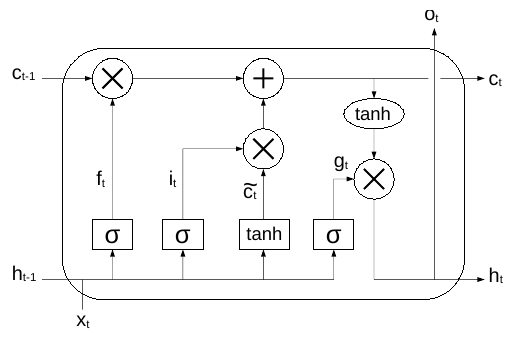
Figure 2. LSTM cell unit. Reproduced under CC-BY from [36].